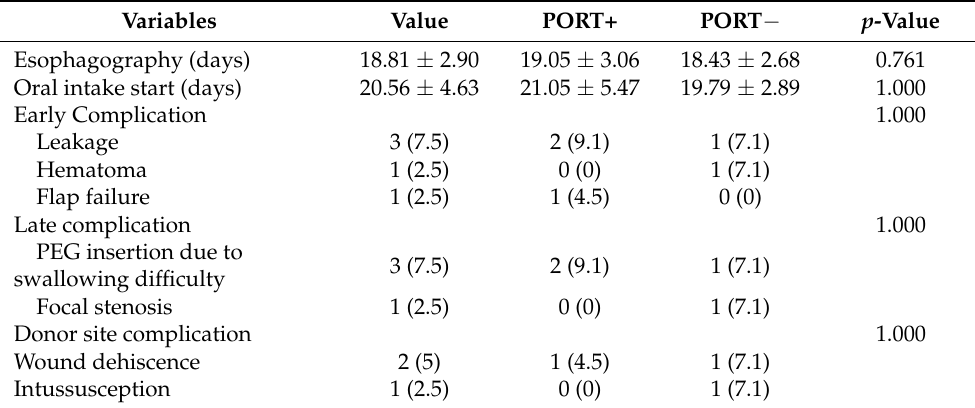
Table 4. Outcome variables